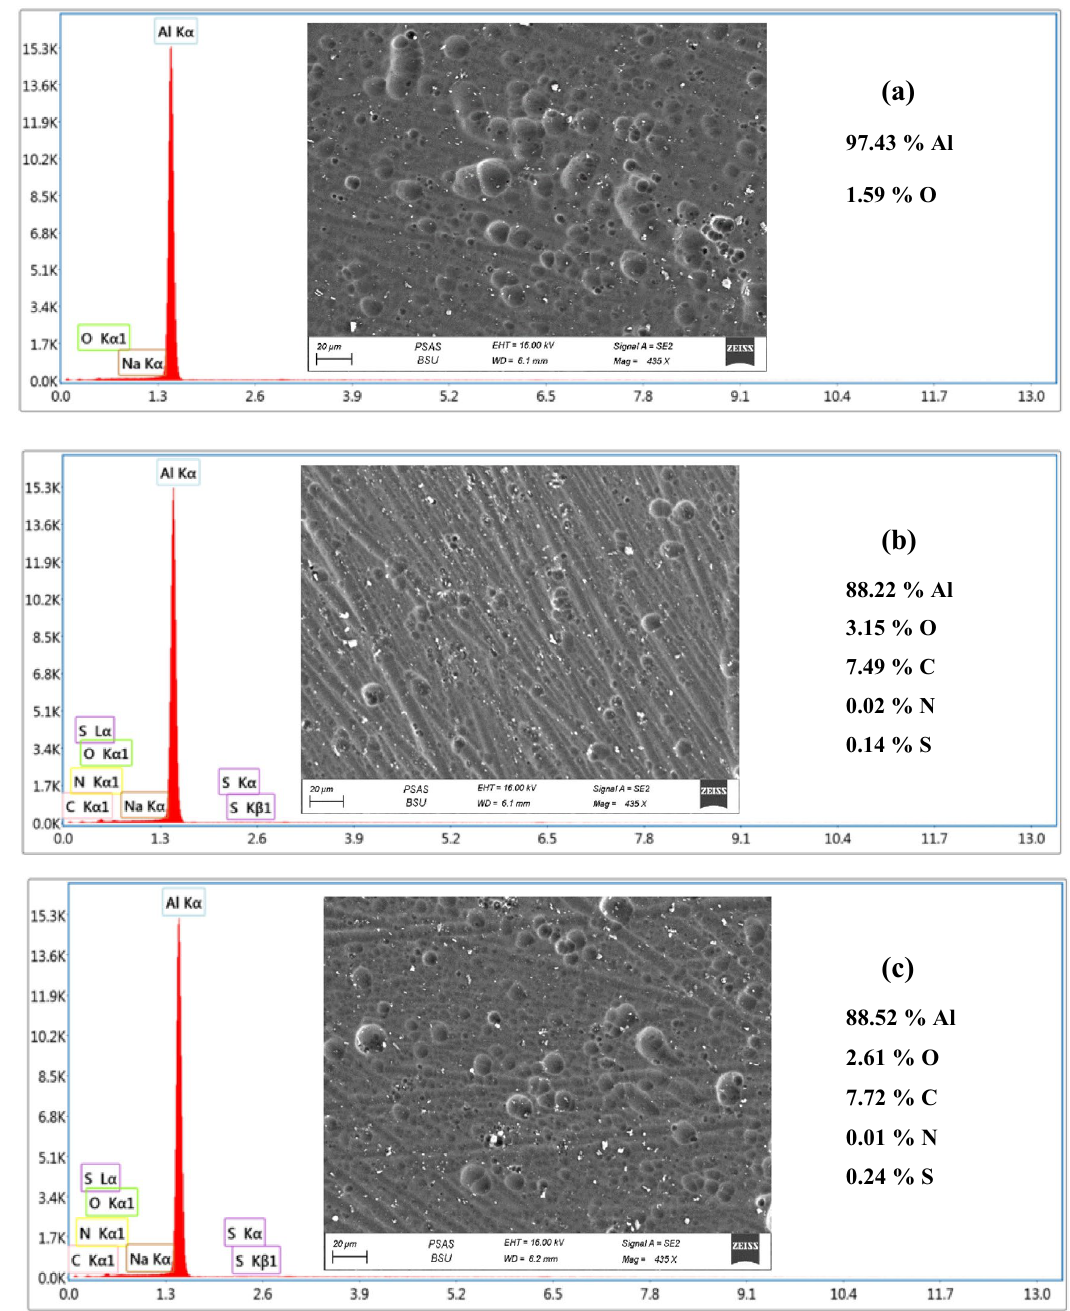
Figure 9. FESEM and EDAX elemental mapping of Al immersed in 0.1 M NaOH solution in the absence and presence of 300 ppm of Cefx and Cefz ( a ) Blank, ( b ) Cefx and ( c ) Cefz at 293 K for 2